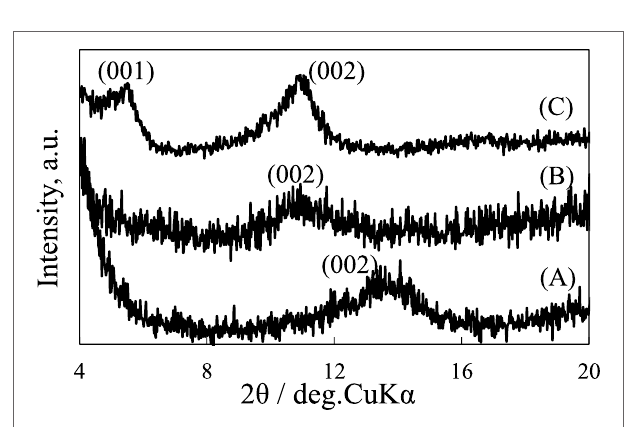
FigUre 5 | Electrical response of pillared carbons obtained from (A)